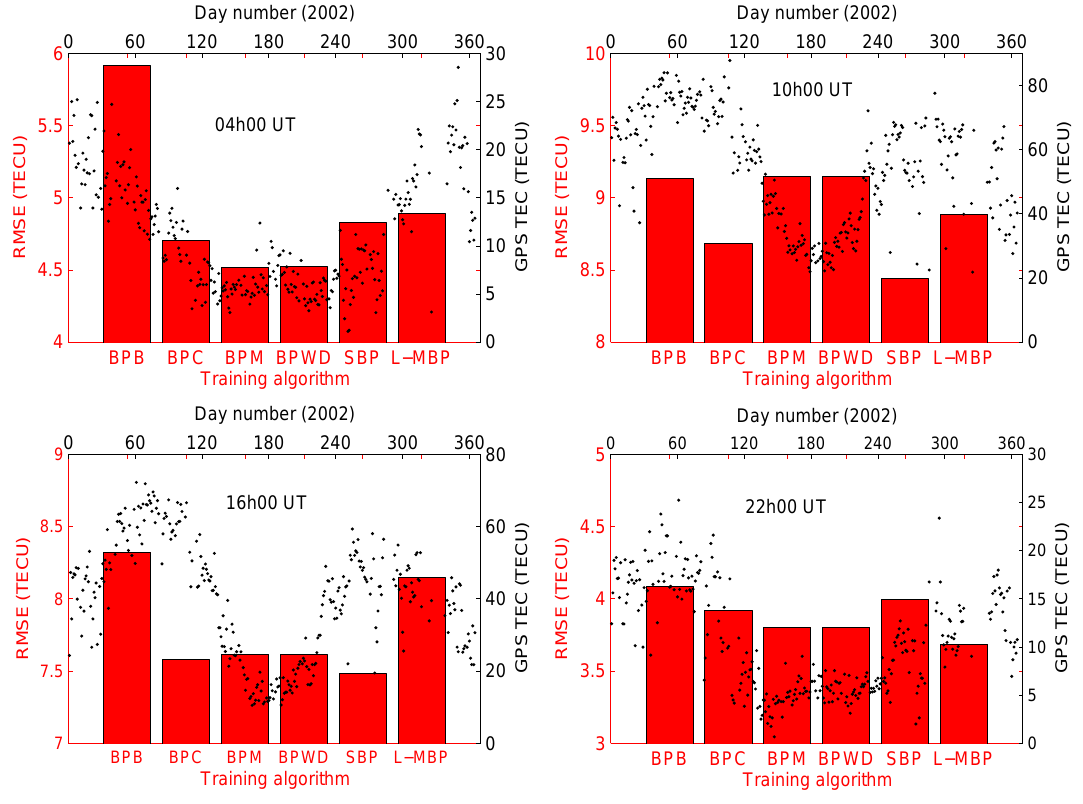
Fig. 4. Similar to Fig. 2, but for CPTN 2002.